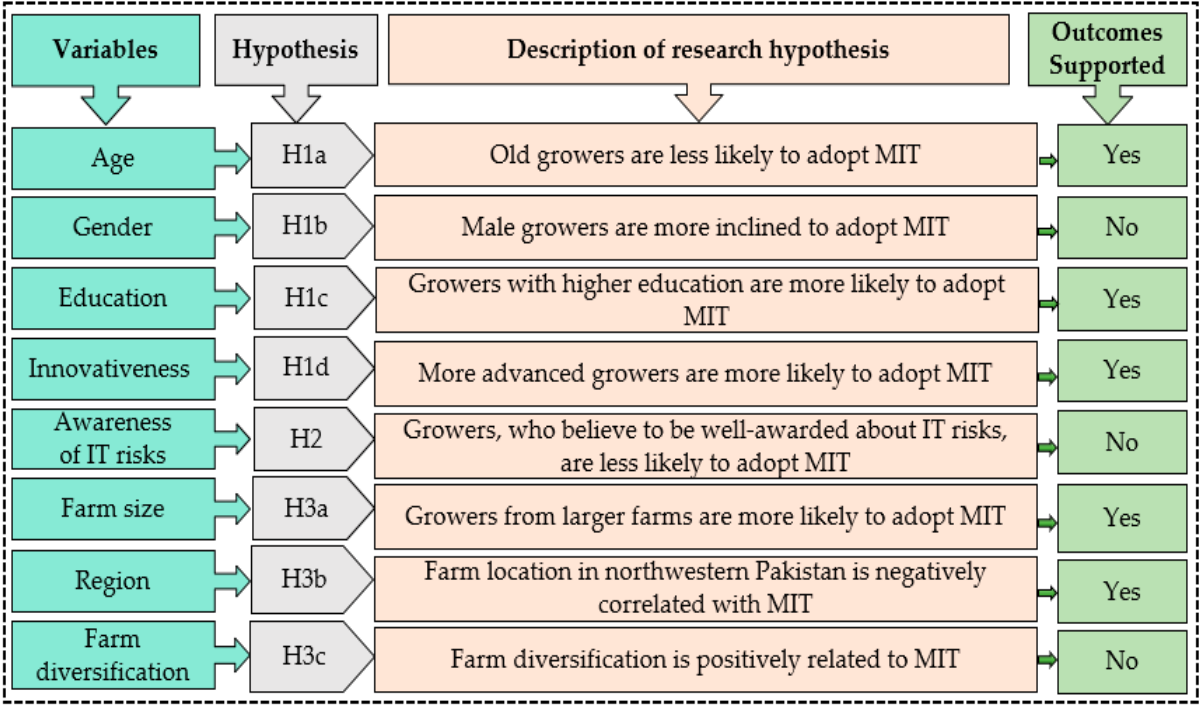
Figure 5. Explanation of the research hypothesis assessment outcomes. According to H1c, the impact of farmer’s education on MIT adoption was